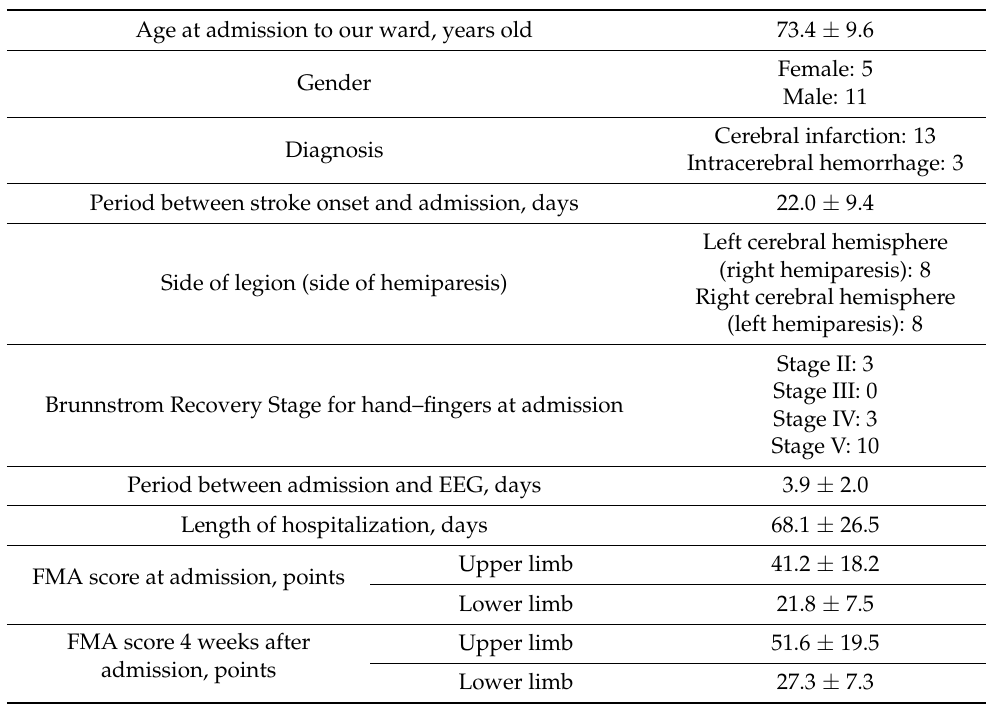
Table 1. Clinical characteristics of studied patients (n = 16).